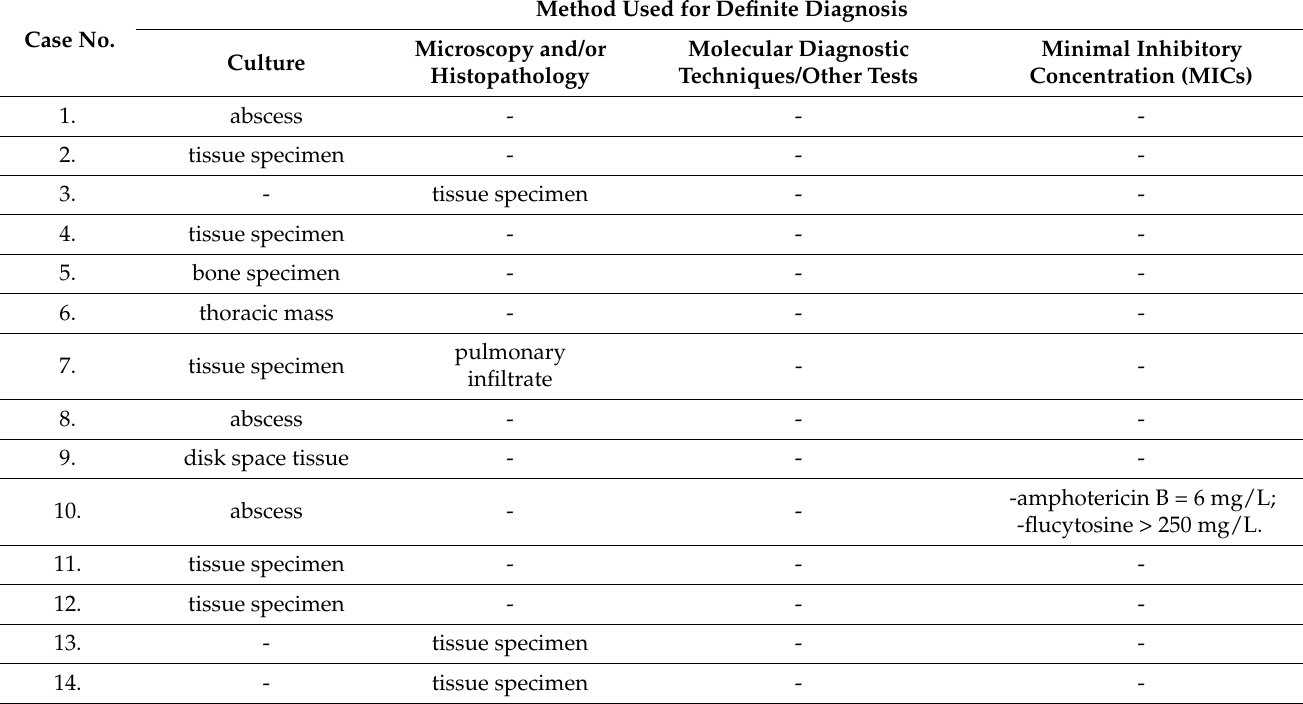
Table 2. Definite diagnosis of spondylodiscitis caused by Aspergillus spp. NR: not reported. (Although the specimen (bone, tissue, abscess, etc.) studied is not reported, the technique is.)